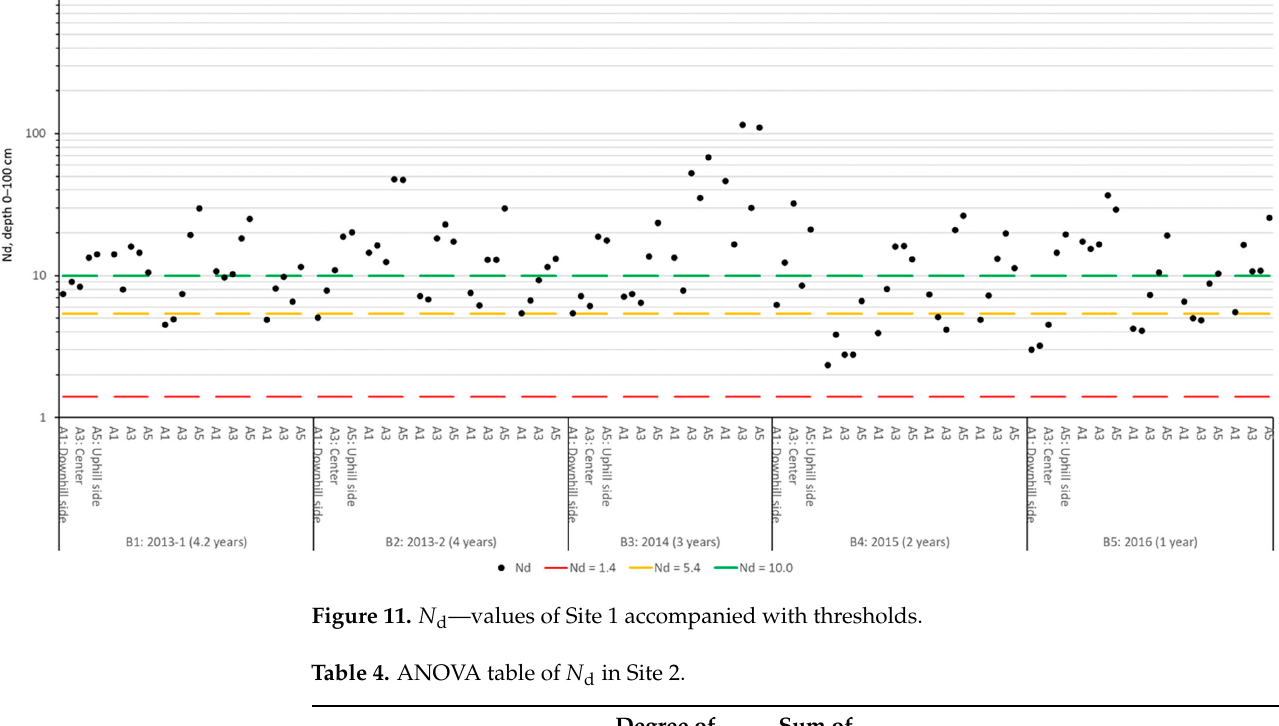
Table 4. ANOVA table of N d in Site 2.